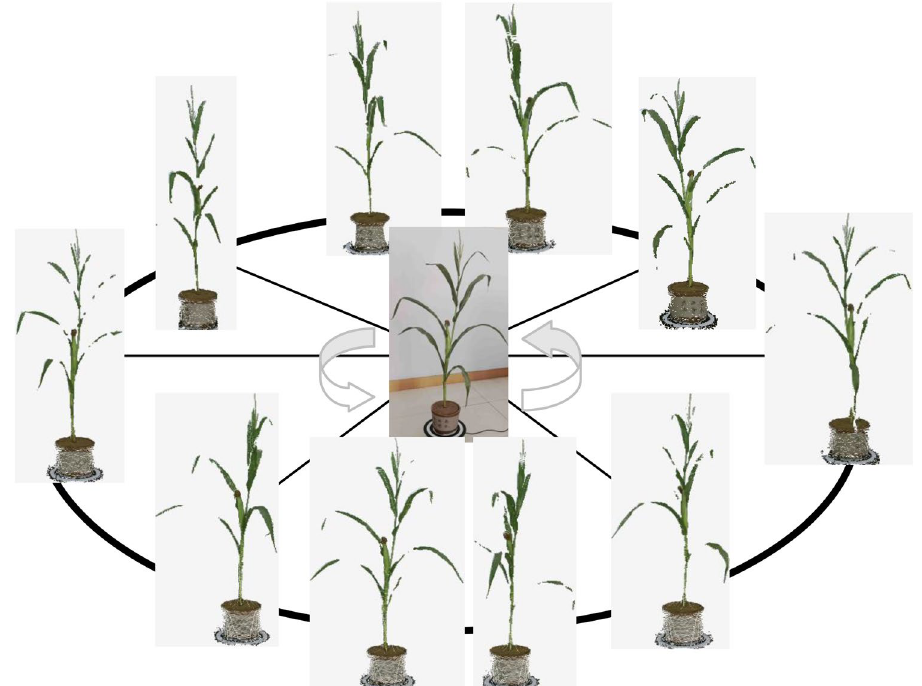
Figure 8. Point clouds from all angles.